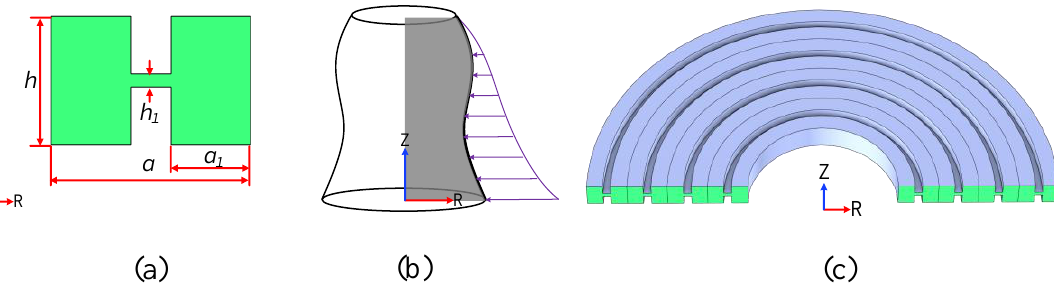
Figure 1. ( a ) The cross section of H-RPC unit cell; ( b ) The formation of RPC; ( c ) The three-dimensional model formed by the rotation of 4-cycle H-RPC structure 180°. Table 1. Parameters of Si Materials. Elastic